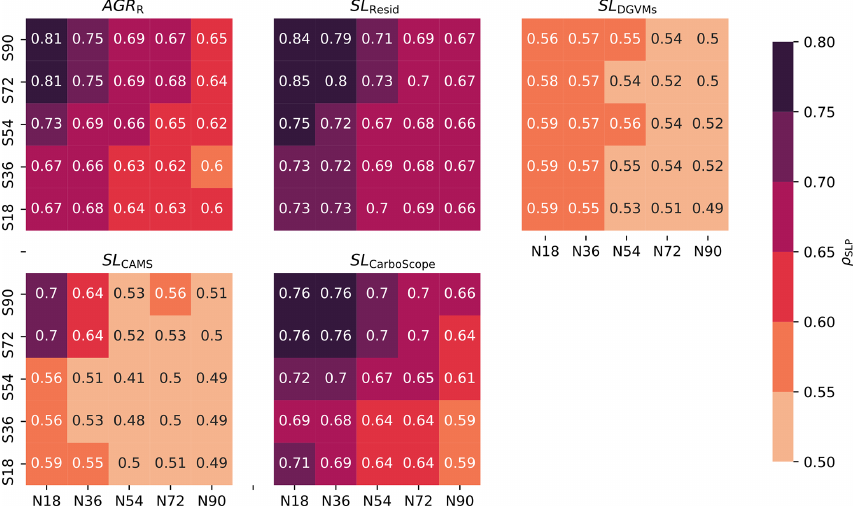
Figure 4. Heat map of predictability with CO 2 time series over various SLP latitude domains in DJF. Each heat map contains 5 × 5 squares, and each square represents one domain of SLP. For example, the square 36 ◦ N–72 ◦ S is the domain of SLP extending from 36 ◦ N to 72 ◦ S. All latitudinal domains include the tropical area (18 ◦ N–18 ◦ S). The top right square thus represents global-scale SLP. ρ SLP of AGR R , SL Resid , SL DGVMs , SL CAMS , and SL CarboScope in 1980–2017 is shown